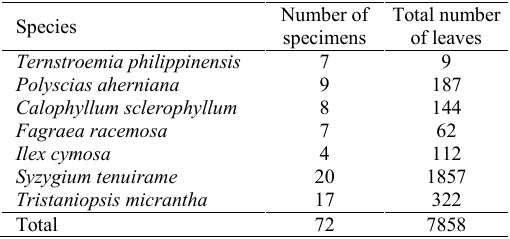
Table 2: Number of leaves measured per specimen.